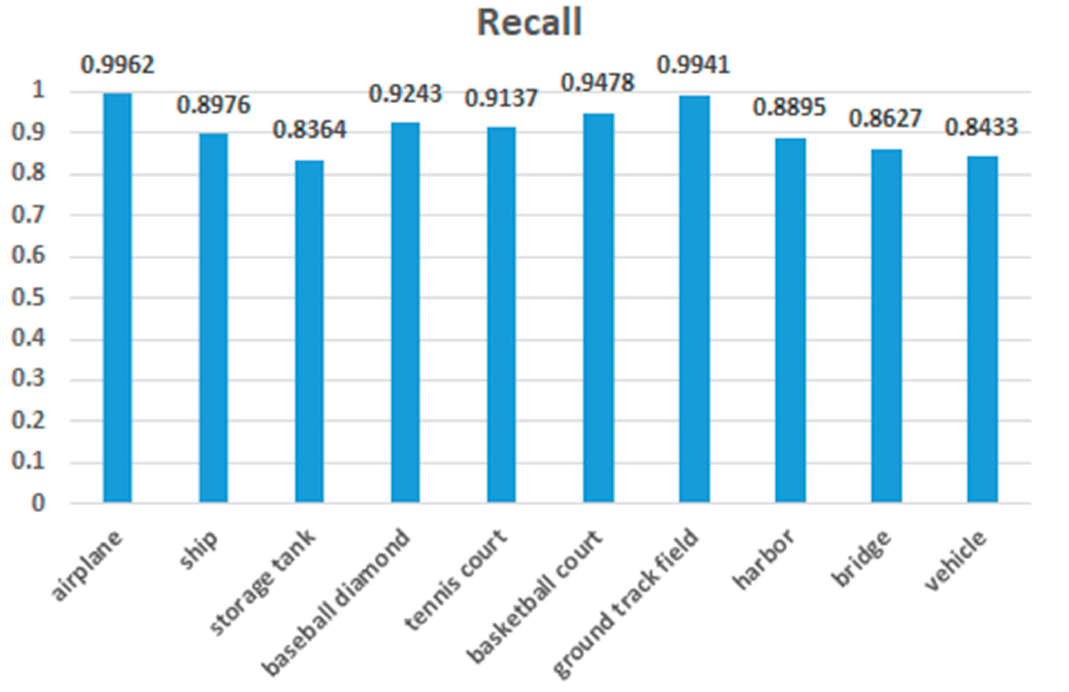
Figure 8. The recall rate for each category of targets of Multi-stage FEPN.